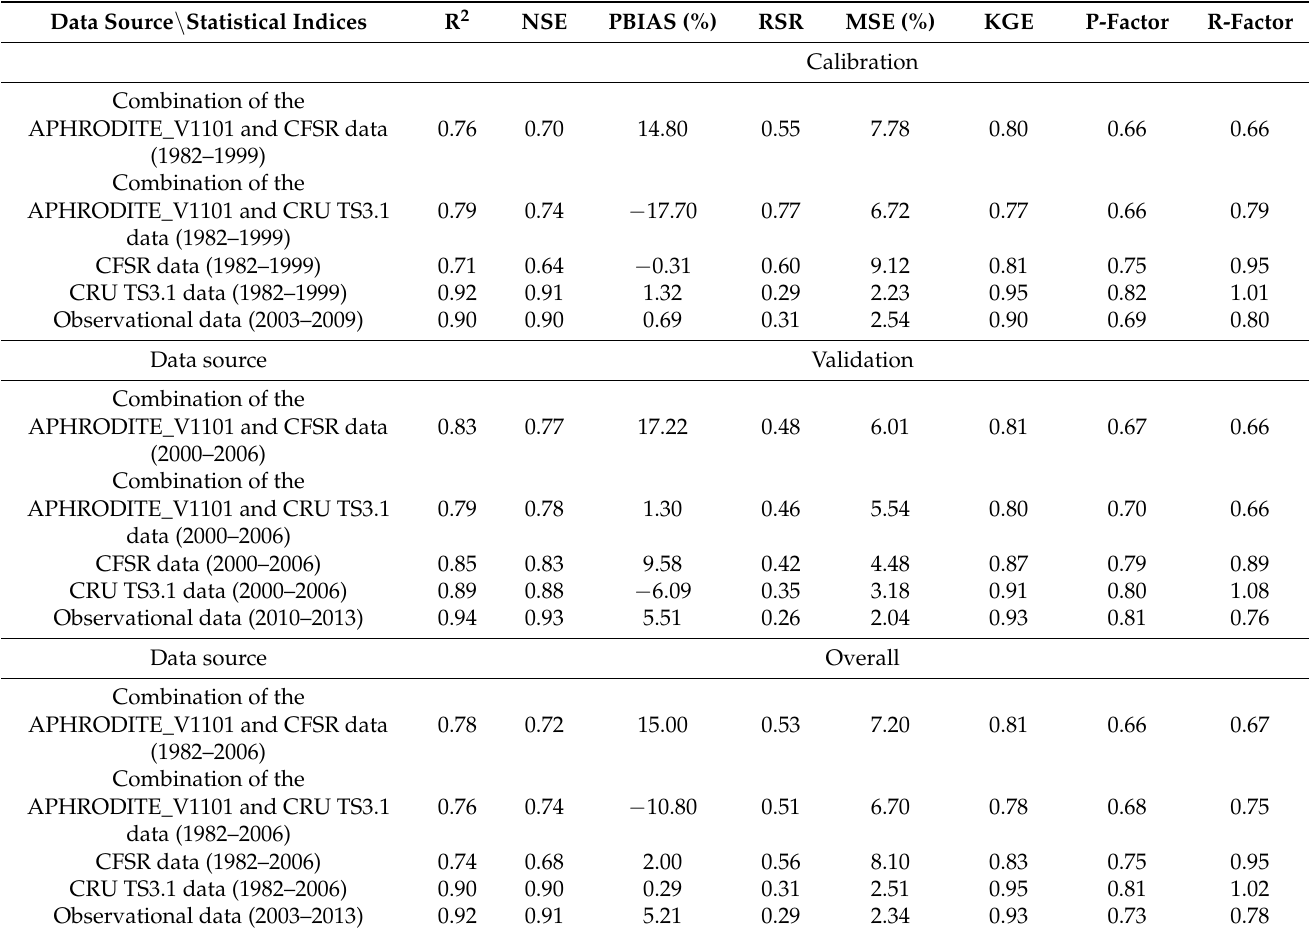
Table 3. Summary statistical indices of monthly streamflow periods with different climate datasets, based on the model’s performance. NSE: Nash–Sutcliffe efficiency; R 2 : coefficient of determination; PBIAS: percentage bias; MSE: mean